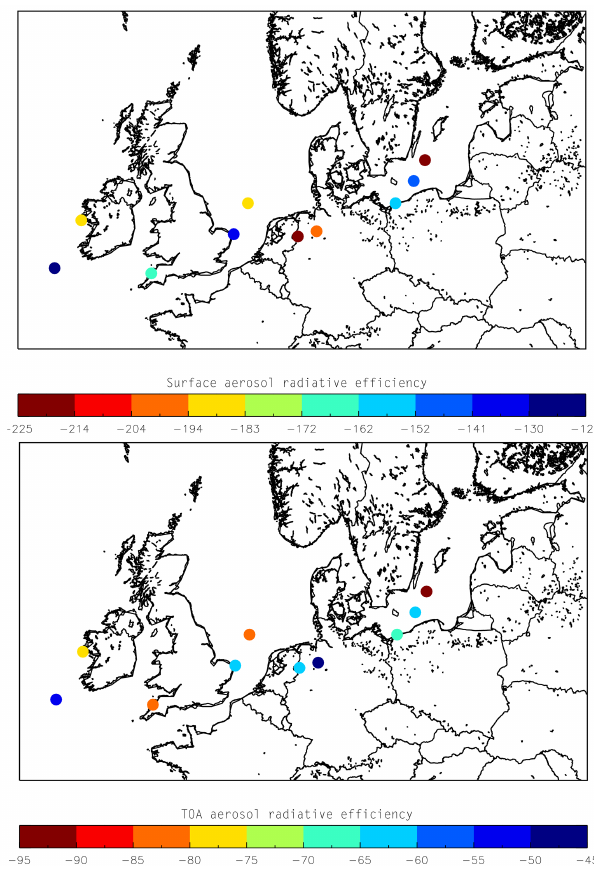
Figure 4. Aerosol radiative efficiency in Wm − 2 per AOD unit at the surface (top) and TOA (bottom) across north-western Europe during